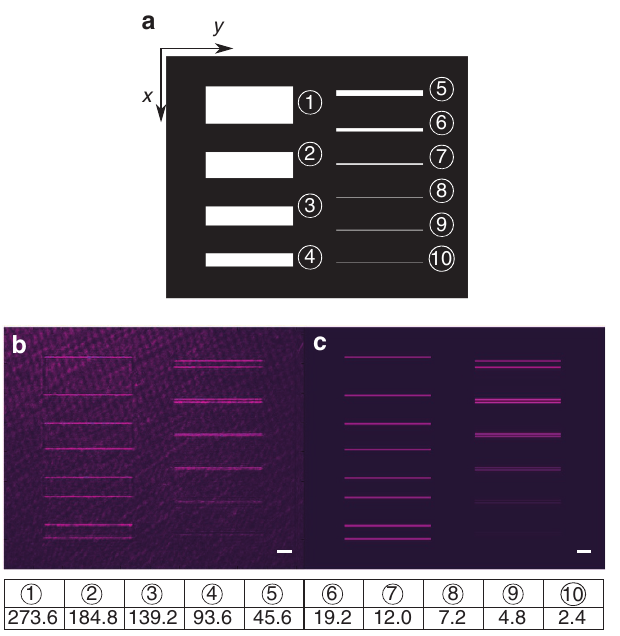
Figure 3 | Spatial resolution test with slot patterns. ( a ) Slot test patterns on the SLM with the different phases for the black and the white areas. ( b , c ) Reflected intensity image by experimental measurement ( b ) and numerical simulations ( c ). The white bars correspond to the length of 100 m m. Inset Table: the widths of the slots used in a in m m.